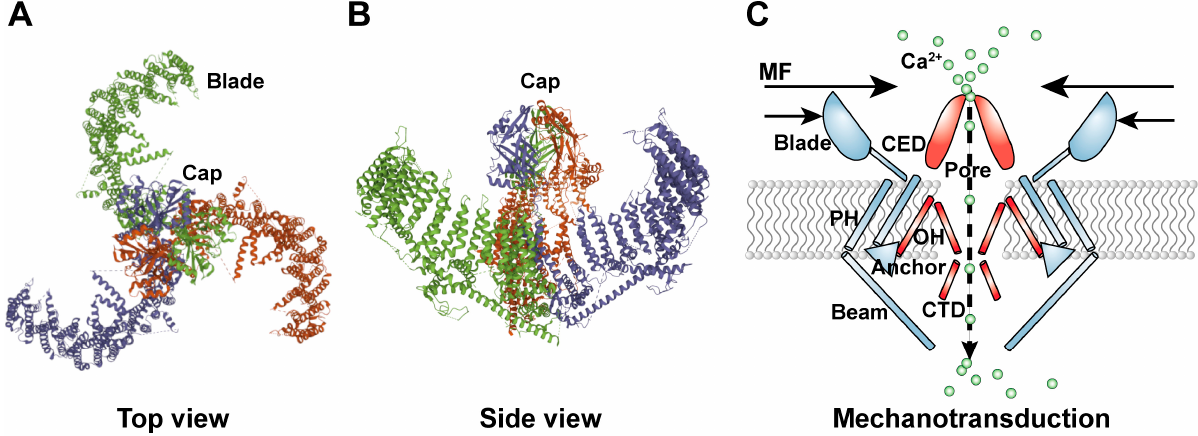
Figure 1. Structure of Piezo1 Channel . ( A ) Top view and ( B ) side view of the Piezo1 ion channel as reported in the Protein Data Bank database (http://www.rcsb.org/pdb/home/home.do, accessed on 10 September 2022, structure ID: 6LQI). The major elements composing the ion channel are shown. ( C ) Schematic diagram of the mechanotransduction and pore modules of the Piezo1 channel. CED: C-terminal extracellular domain; CTD: intracellular C-terminal domain; MF: mechanical forces; OH: outer helix; PH: peripheral